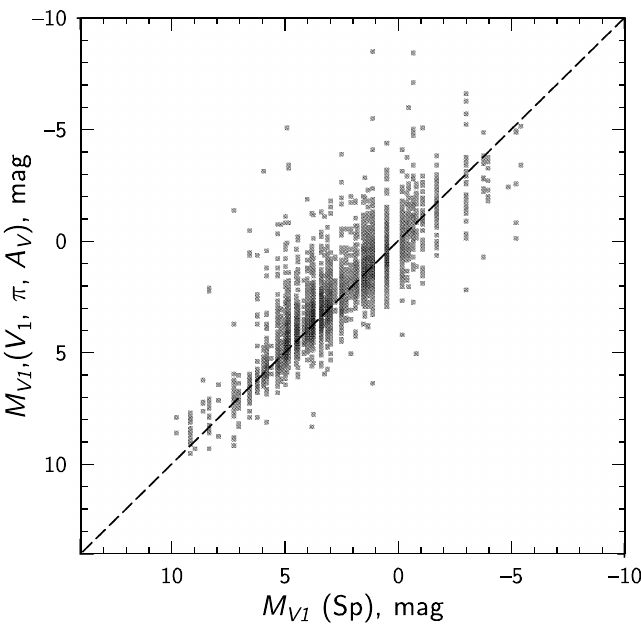
Fig. 4. Luminosity class V pairs: the spectroscopic absolute magnitudes of primaries versus the absolute magnitudes determined from trigonometric parallax, apparent mag- nitude, and interstellar extinction. Primaries with ∆ M v > 2 mag are excluded from further investigation as possibly misclassified luminous